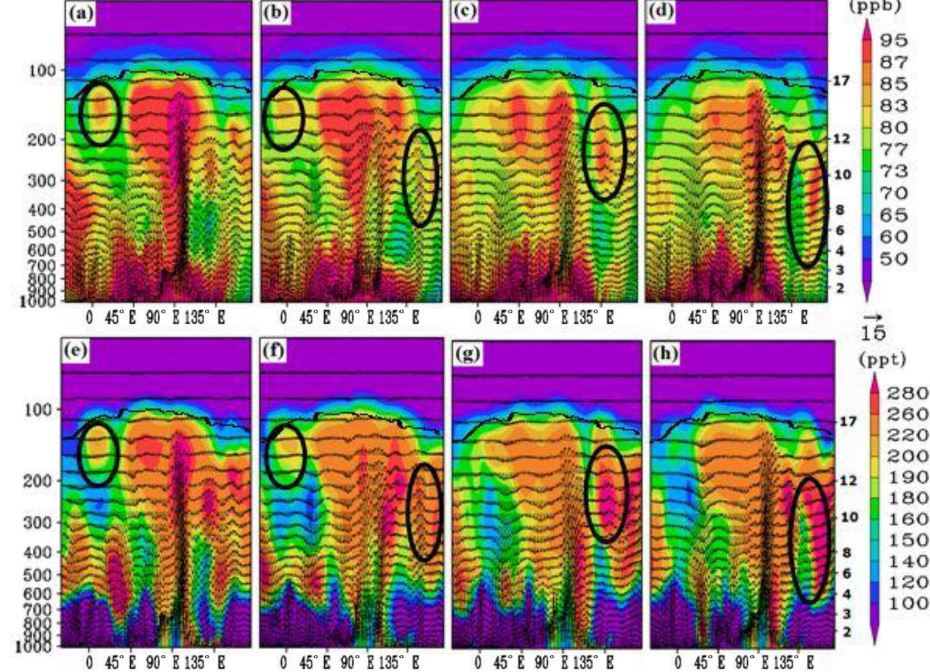
Figure 7. Longitude-pressure section (averaged for 20–40 ◦ N) of CO (ppb) from ECHAM5-HAMMOZ CTRL simulation for (a) 2 July, (b) 4 July, (c) 6 July and (d) 8 July 2003. (e) – (h) same as (a) – (d) but for PAN (ppt). Thick black line indicates the tropopause and black dotted circles indicate maximum amounts of CO and PAN near eddies. Pressure (hPa) is indicated on the left y axis and altitudes (km) on the right y axis. Wind vectors (ms − 1 ) are shown by black arrows. Vertical velocity field is scaled by a factor of